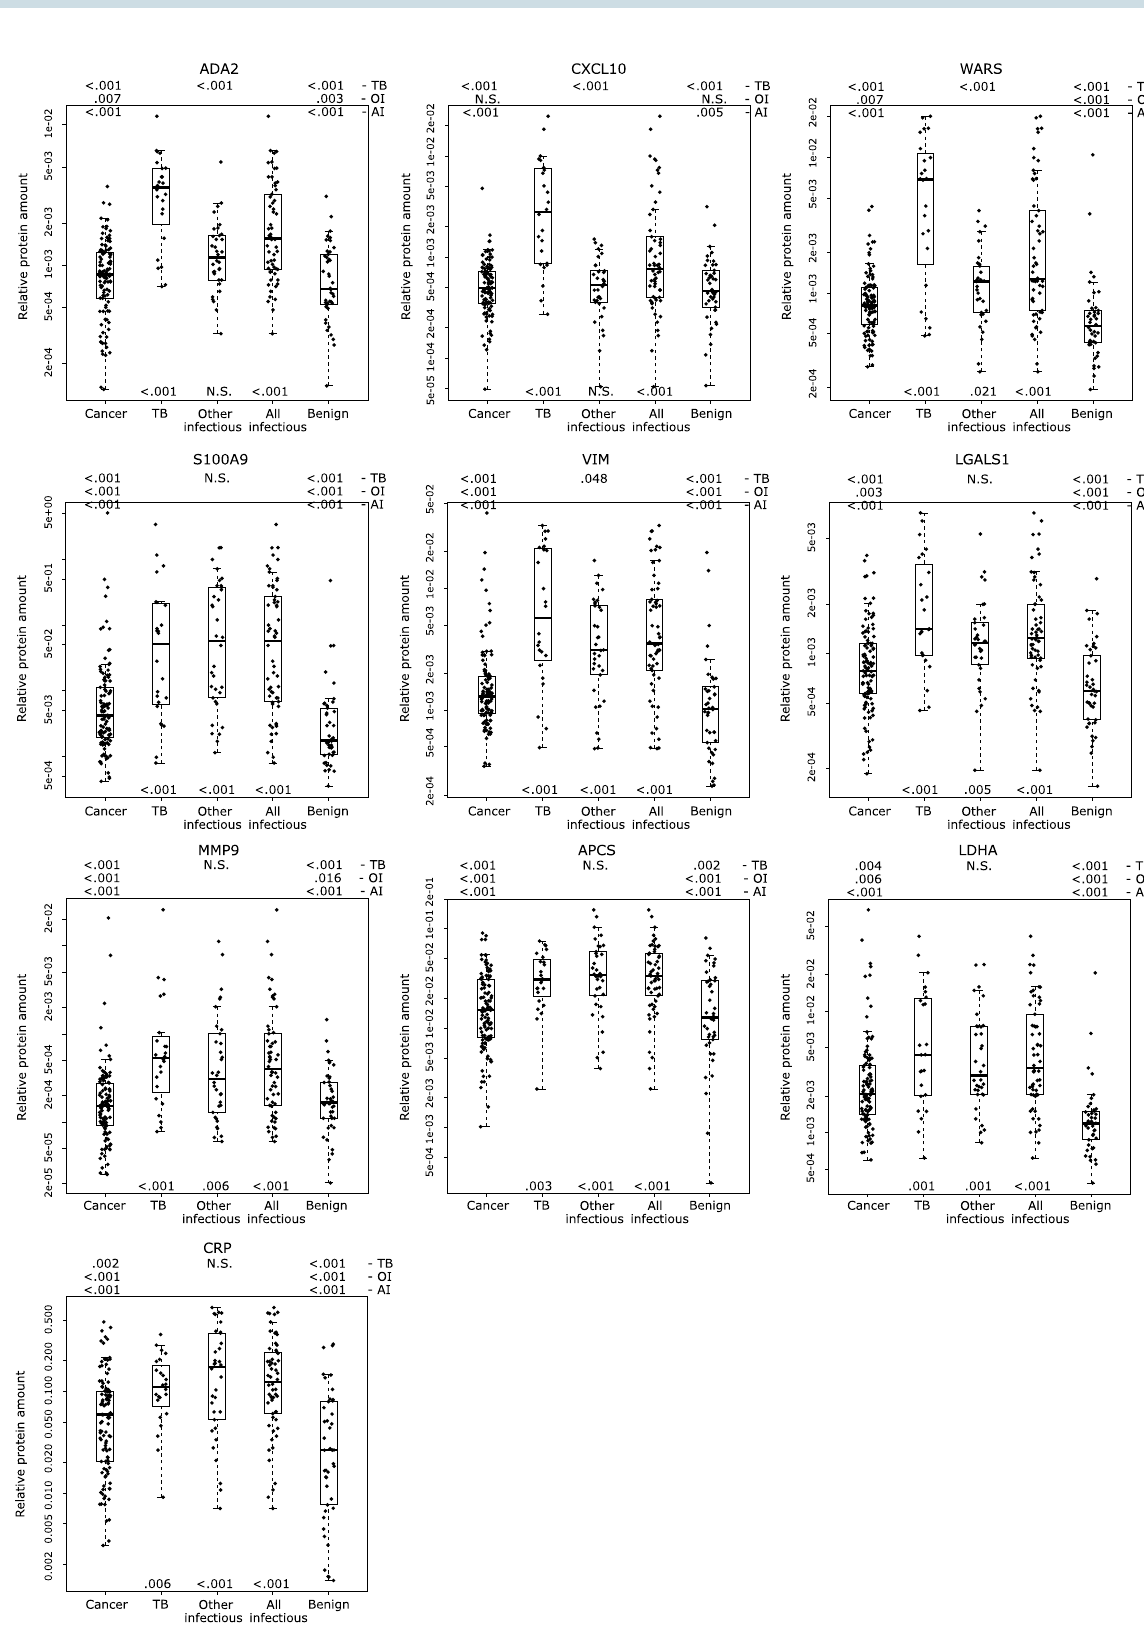
Figure 2. Proteins significantly elevated in the TB and infectious PEs. Relative protein amounts in 209 patient PEs. Statistical significance (Mann–Whitney U test p-value) is indicated above the graphs for the comparison of the TB-PEs (TB), other-infectious- PEs (OI), or all-infectious PEs (TB-PEs and other-infectious-PEs combined: AI) vs. cancerous-PEs, other-infectious-PEs, or benign- PEs (value above each group). Below the graphs are indicted p-values for the comparison of the TB-PEs, other-infectious-PEs, or all-infectious PEs vs. all other PEs combined. Other MWU test results can be found in Table 2. Box-plots indicate the median and quartiles, with whiskers indicating the 1.5 interquartile